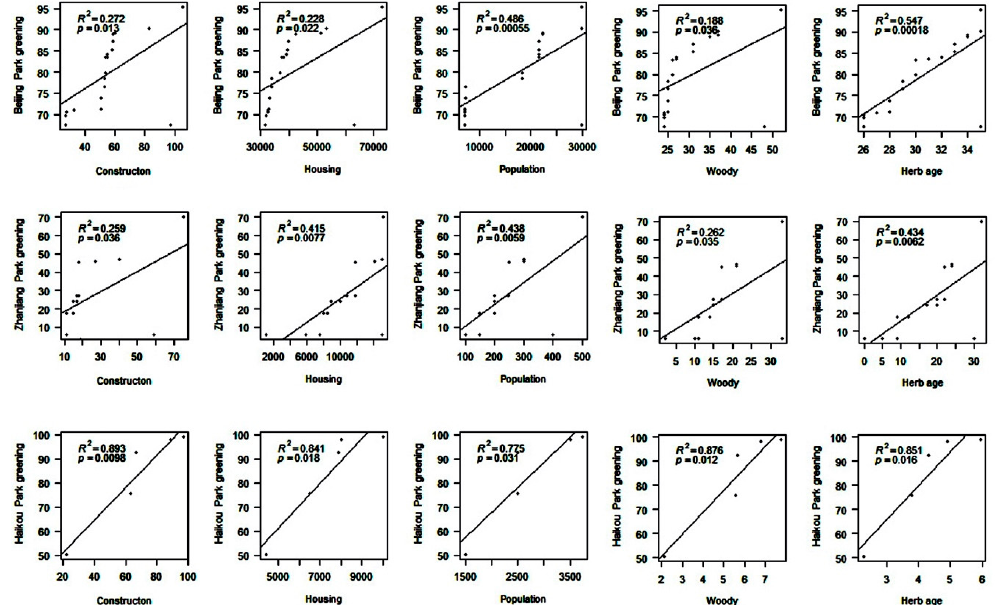
Figure 6. Scatterplots depicting the relationships between the greening percentages of Parks and both socioeconomic variables (construction age, housing price, and population density) and species richness (woody and herbaceous) within Beijing, Zhanjiang, and Haikou.